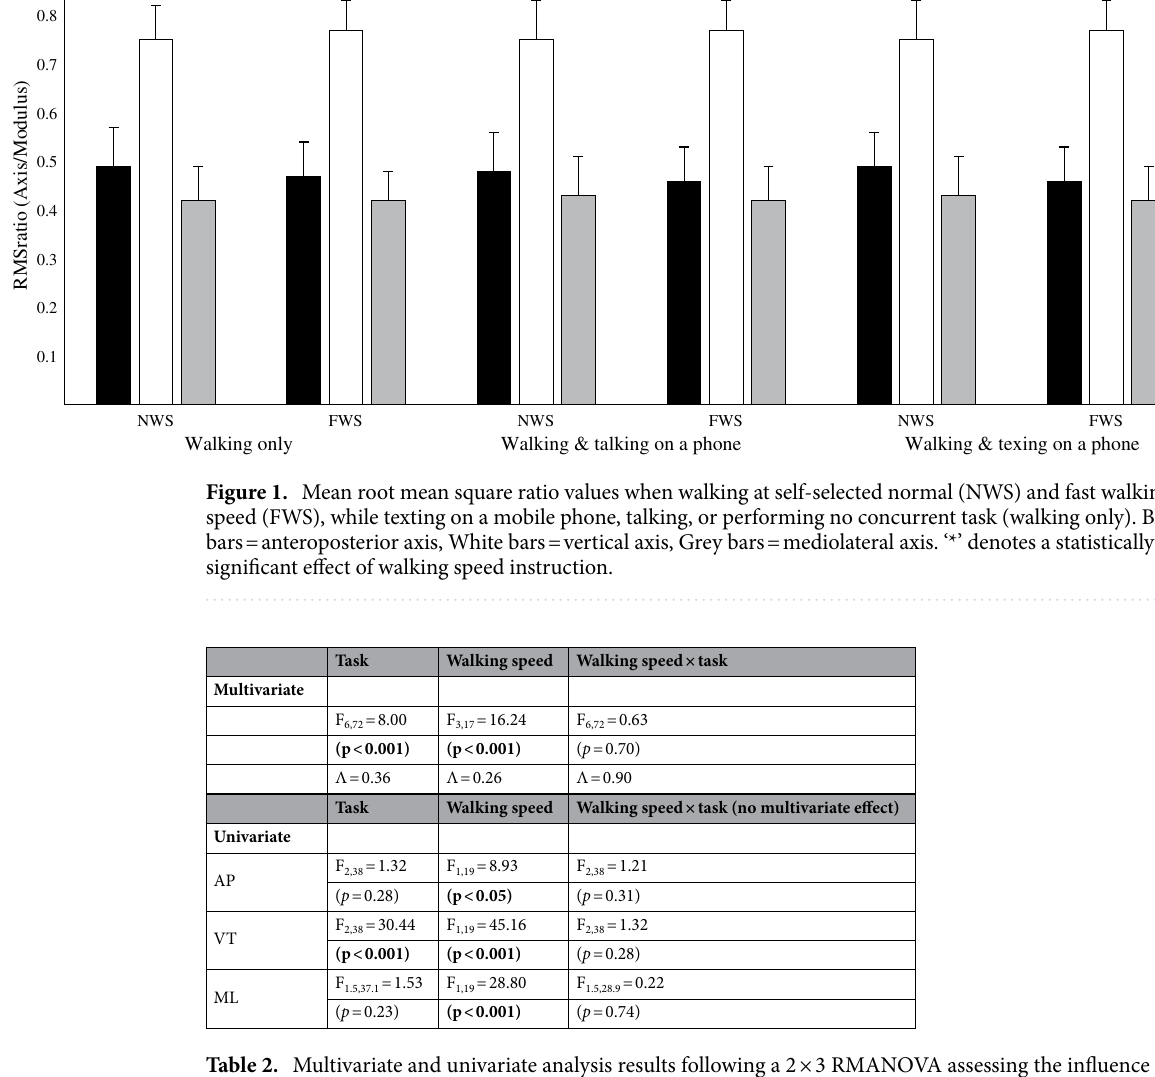
Table 2. Multivariate and univariate analysis results following a 2 × 3 RMANOVA assessing the influence of walking speed instruction and task on entropy (SaEn). ‘Λ’ denotes Wilk’s lambda; ‘F’ denotes the F-statistic (extent of the difference between group means). ‘ p ’ denotes the statistical significance; the threshold for significance was set at p < 0.05. ML mediolateral measurement axis, VT vertical measurement axis, AP anteroposterior measurement